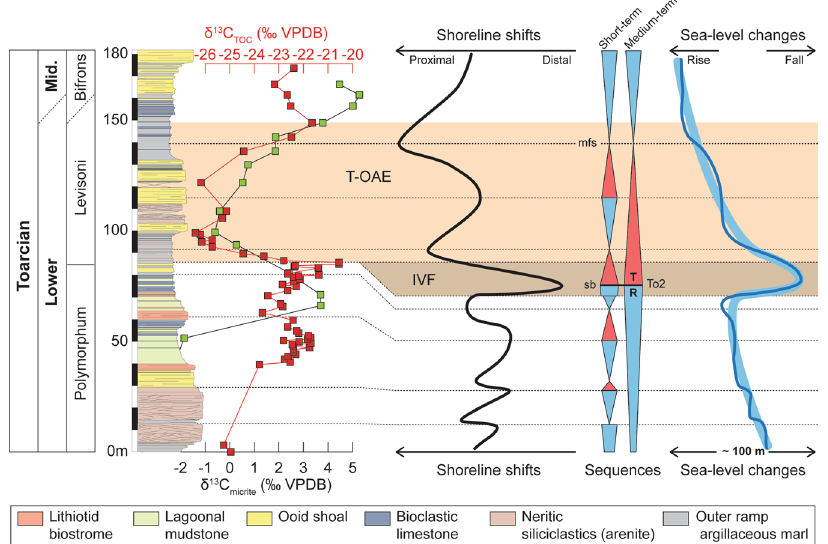
Figure 3. Summary of shoreline shifts and inferred sea-level changes as deduced from the Dades Valley record. The time interval encompassed by the infilling unit is lacking on the Dades Valley composite section (hiatus surface) as this later was logged in Jebel Toksine, ca. 4 km further downdip from the Jebel Akenzoud 13